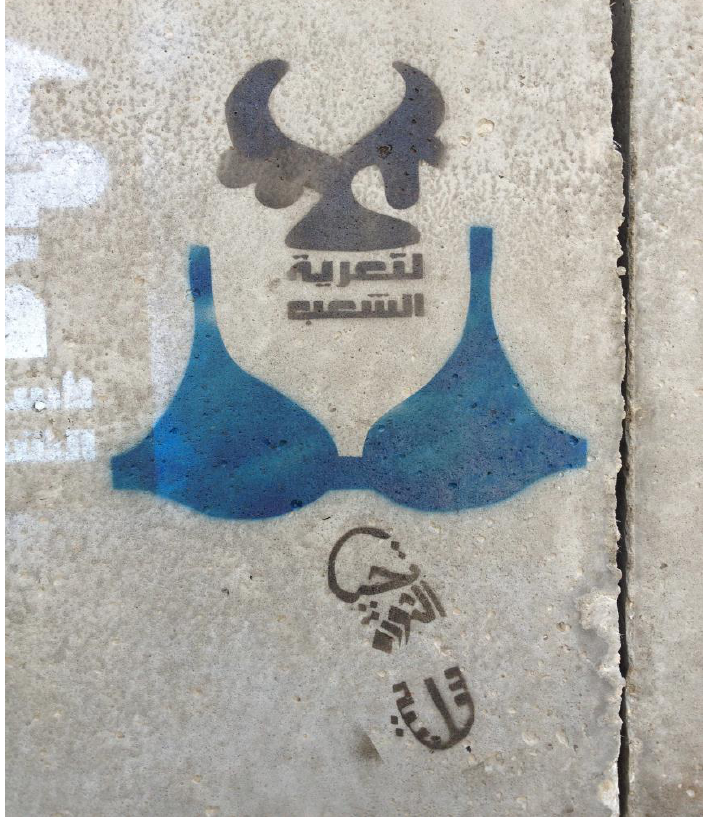
Figure 4. Bahia Shehab, “No to Stripping the People,” 2011, used with permission from the artist.